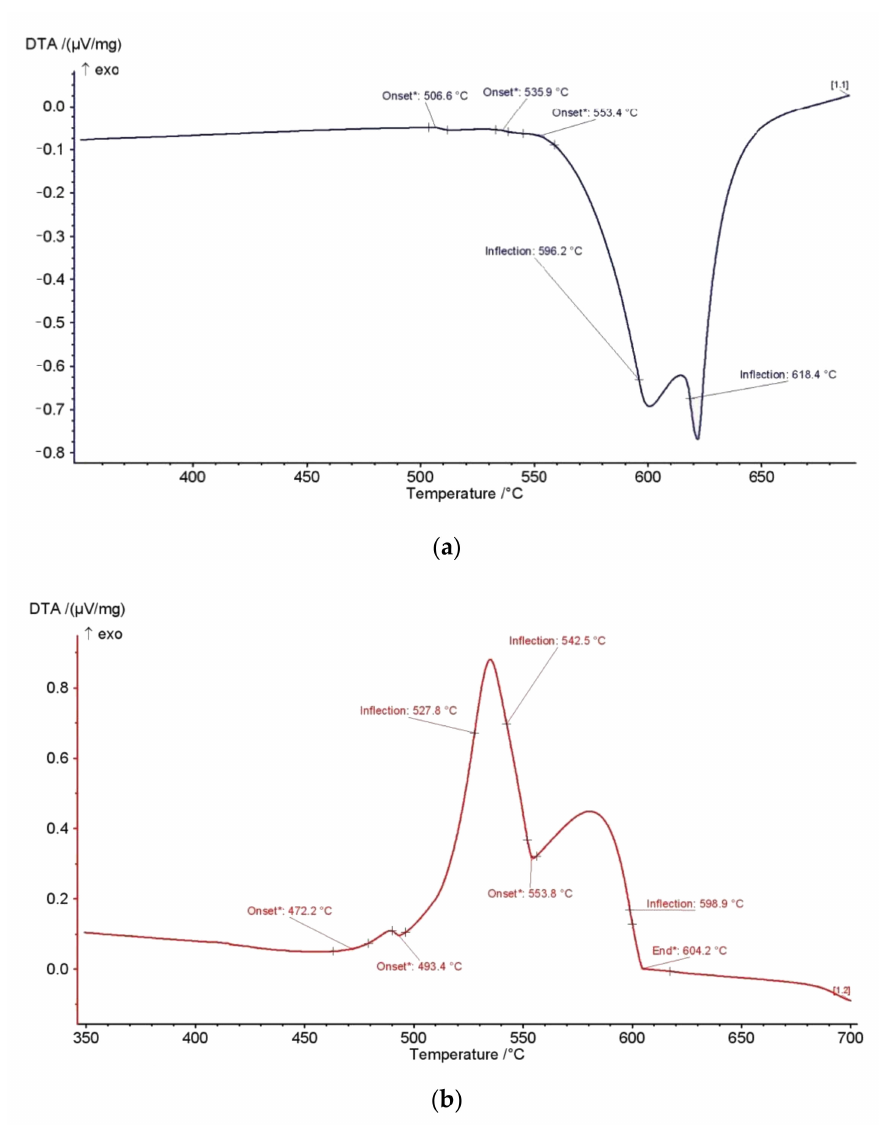
Figure 7. Simultaneous thermal analysis of AlSi7MgCu alloy: ( a ) heating curve, ( b ) cooling curve. The heating and cooling curves of AlSi7MgCu alloy resulted in establishing the exact temperatures of phase transformations and precipitation, as shown in Table 5. Heating and cooling curve temperatures di ff er slightly due to energy output dedicated to di ff erent melting and solidification phenomena. Additionally, the heating curve did not indicate energy changes connected to all phases identified by microstructural analysis. The only strong signal related to phase transition was detected at liquidus temperature corresponding to dendrite network development. Other signals were di ff used, indicating the strong interaction of a number of elements during the solidification process. Comparison of the solidification path predicted based on the equilibrium phase diagram modelling with those from simultaneous thermal analysis and microstructural investigations allowed the solidification sequence determination of AlSi7MgCu alloy listed in Table